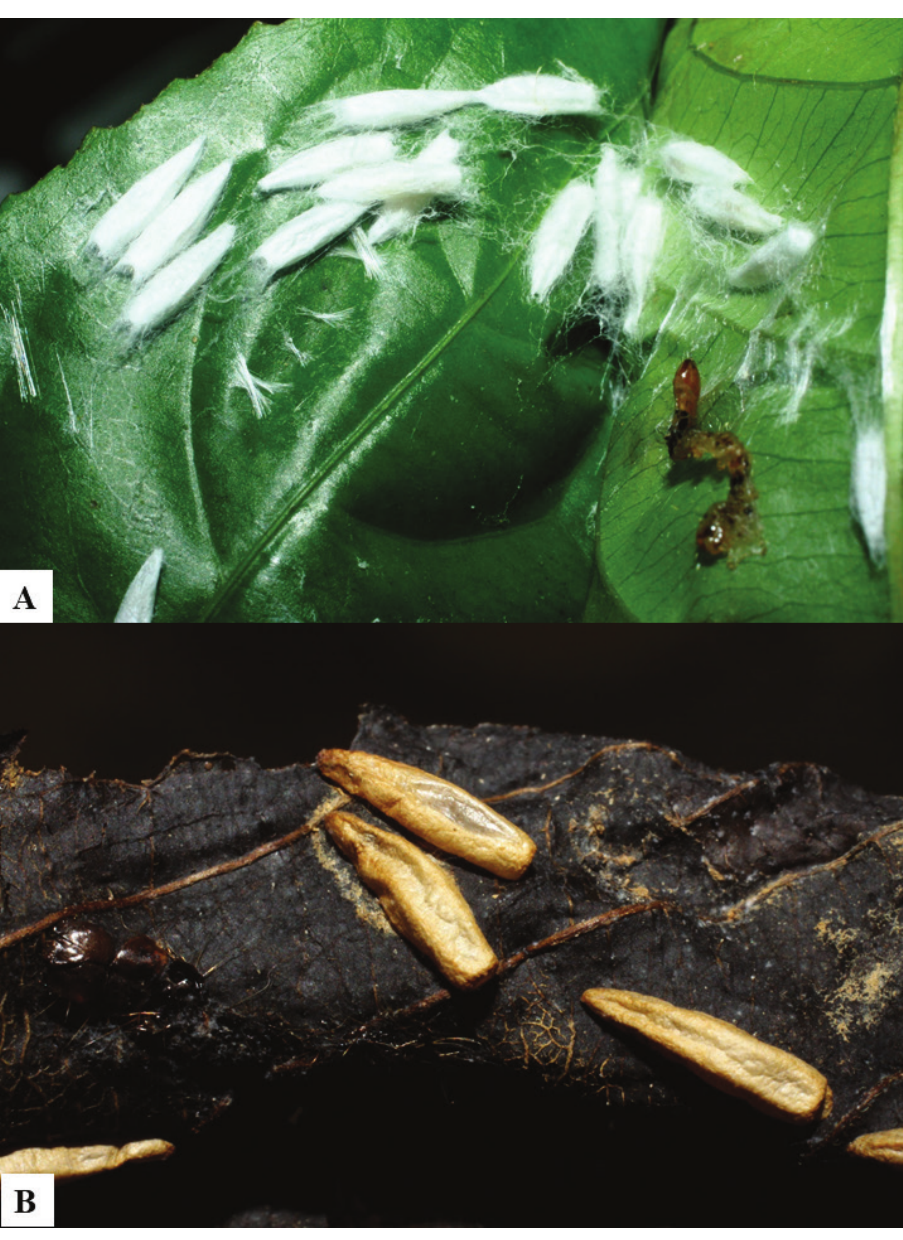
Figure 16. A, B Cocoons of Dolichogenidea rogerblancoi sp.